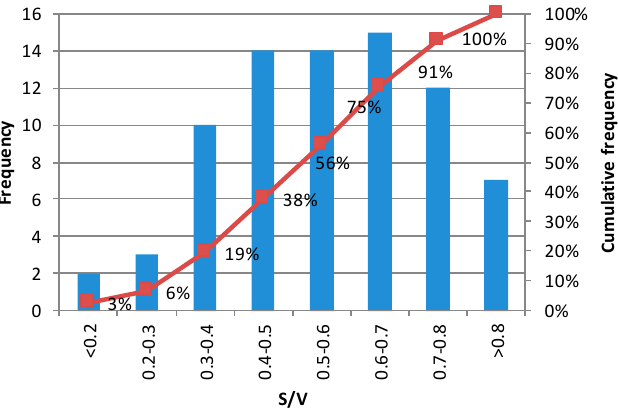
Figure 5. Frequency distribution of schools in terms of S/V ratio.